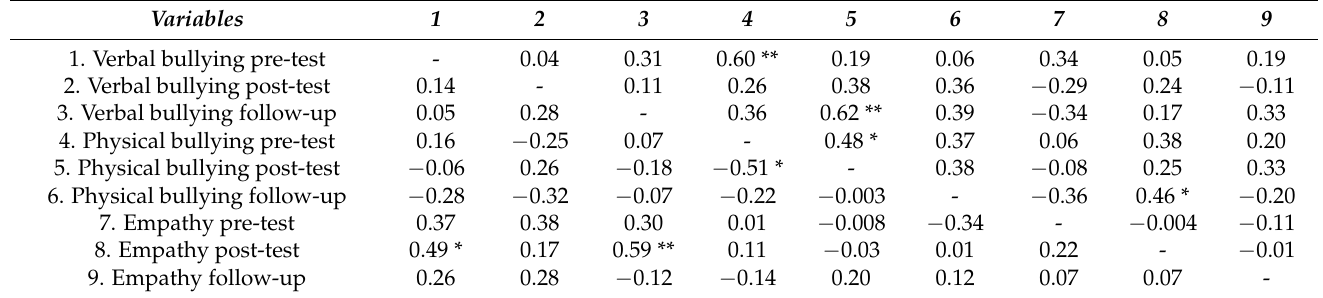
Table 5. Correlations within experimental group 1/experimental group